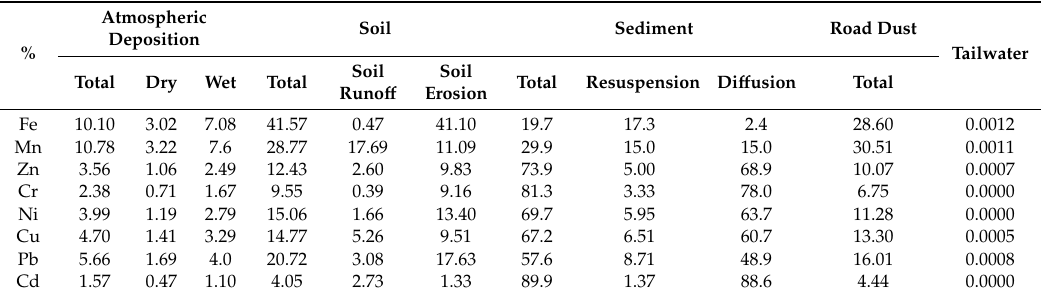
Table 4. The contribution ratios of the other environmental media to metals in urban water